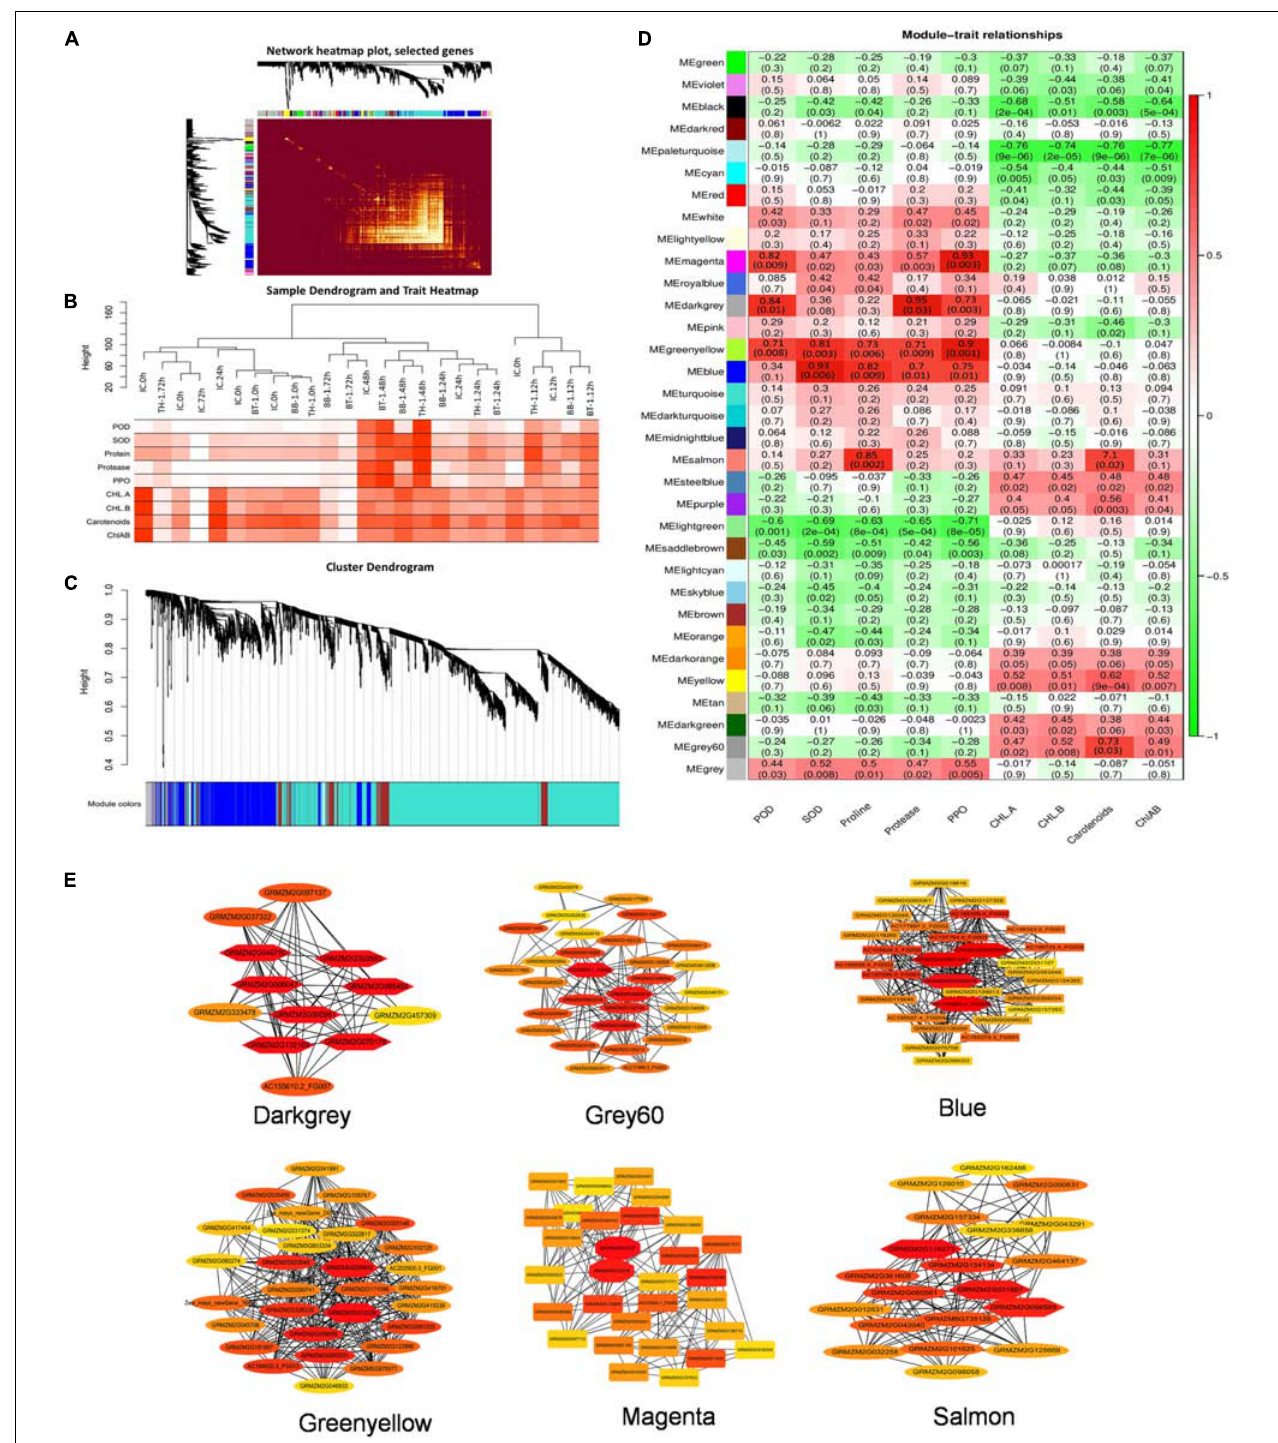
FIGURE 5 | Weighted gene coexpression network analysis (WGCNA) analysis to identify key candidate genes involved in maize defense. (A) Cluster dendrogram and network heatmap of genes subjected to coexpression module calculation. (B) Sample dendrogram and module trait heatmap of each time point. (C) Hierarchical clustering presenting eleven modules having coexpressed genes. Each leaflet in the tree corresponds to an individual gene. (D) Module-trait associations based on Pearson correlations. The color key from green to red represents r 2 values ranging from –1 to 1. (E) Gene networks of six highly correlated modules with phenotypic traits. Genes in different red shape due to the highest weight within the module represents hub genes (key candidate genes) and are coded for gene descriptors based on annotation. Treatments include (BB-1) seed treatment with B. bassiana OFDH1-5, (TH-1) seed treatment with T. asperellum GDFS1009, (BT-1) seed treatment with a consortium of B. bassiana OFDH1-5 and T. asperellum GDFS1009, (IC) no inoculation.